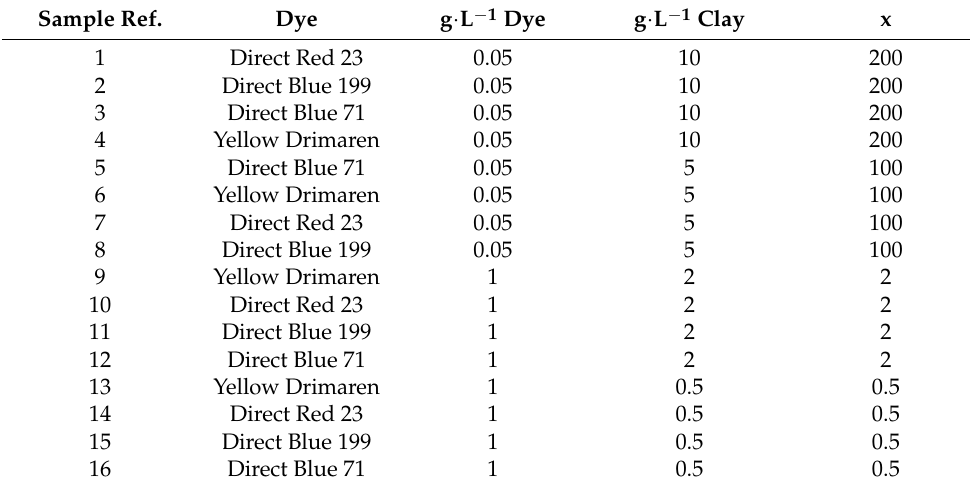
Table 7. Samples and their concentrations under experimental conditions according to the general full factorial DoE 4 2 . Sample